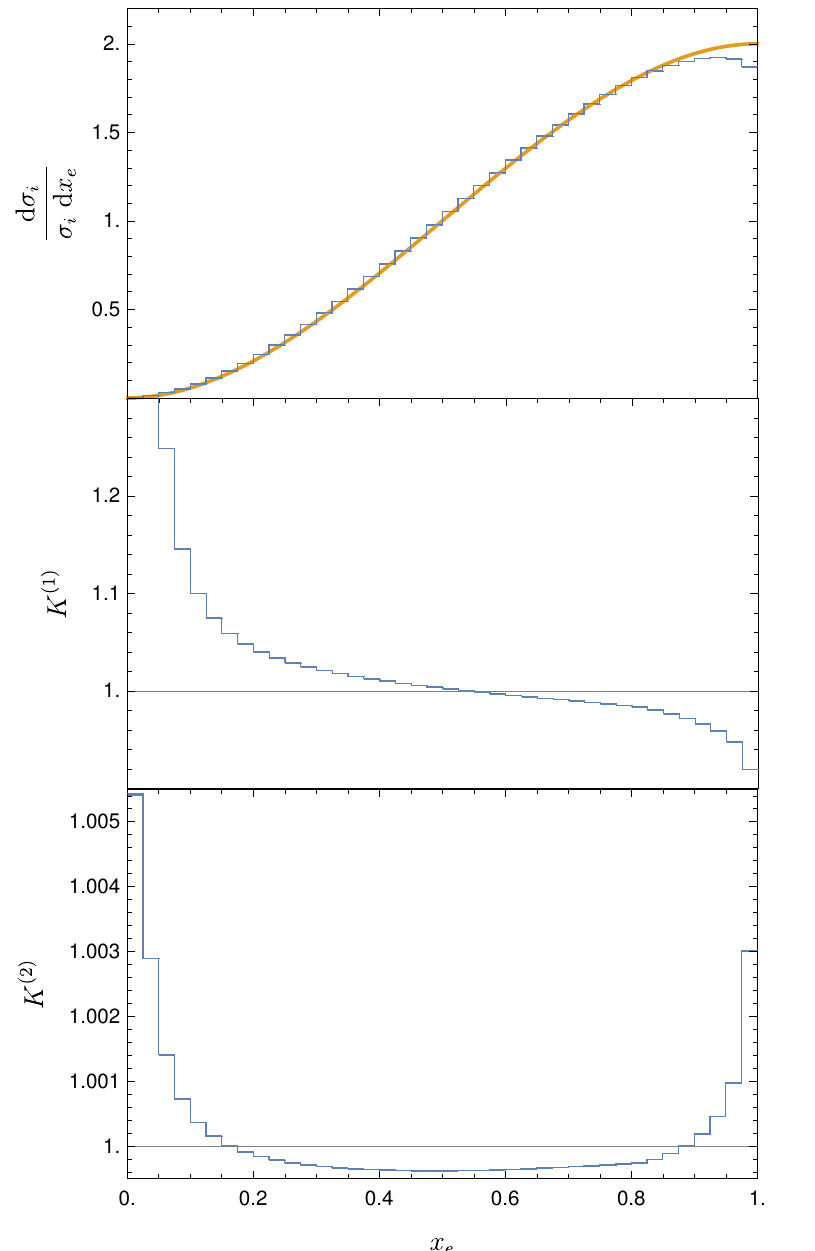
Figure 5 . Top panel: the normalised electron energy spectrum at LO (orange line) and NNLO (blue histogram) with a cut on photon emission. The middle and bottom panel show the NLO and NNLO K factors, respectively.